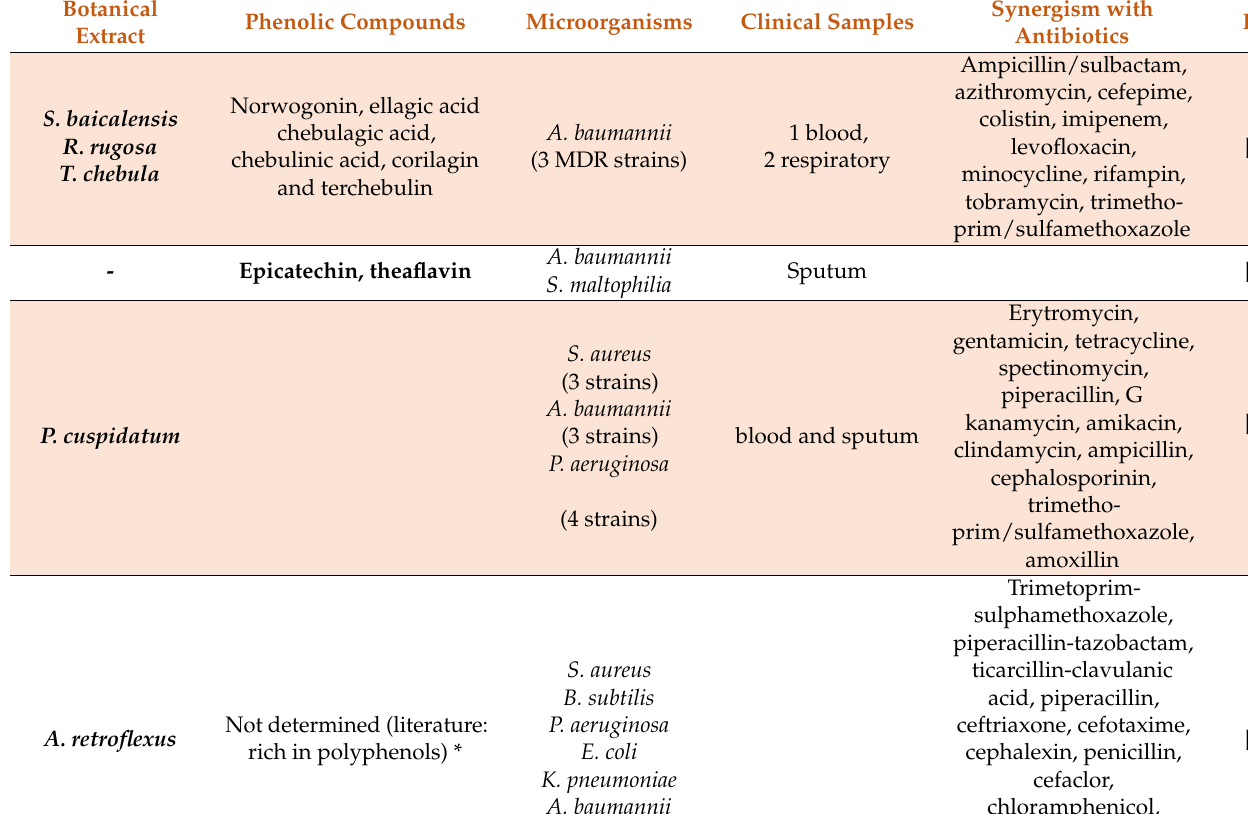
Synergism with Antibiotics